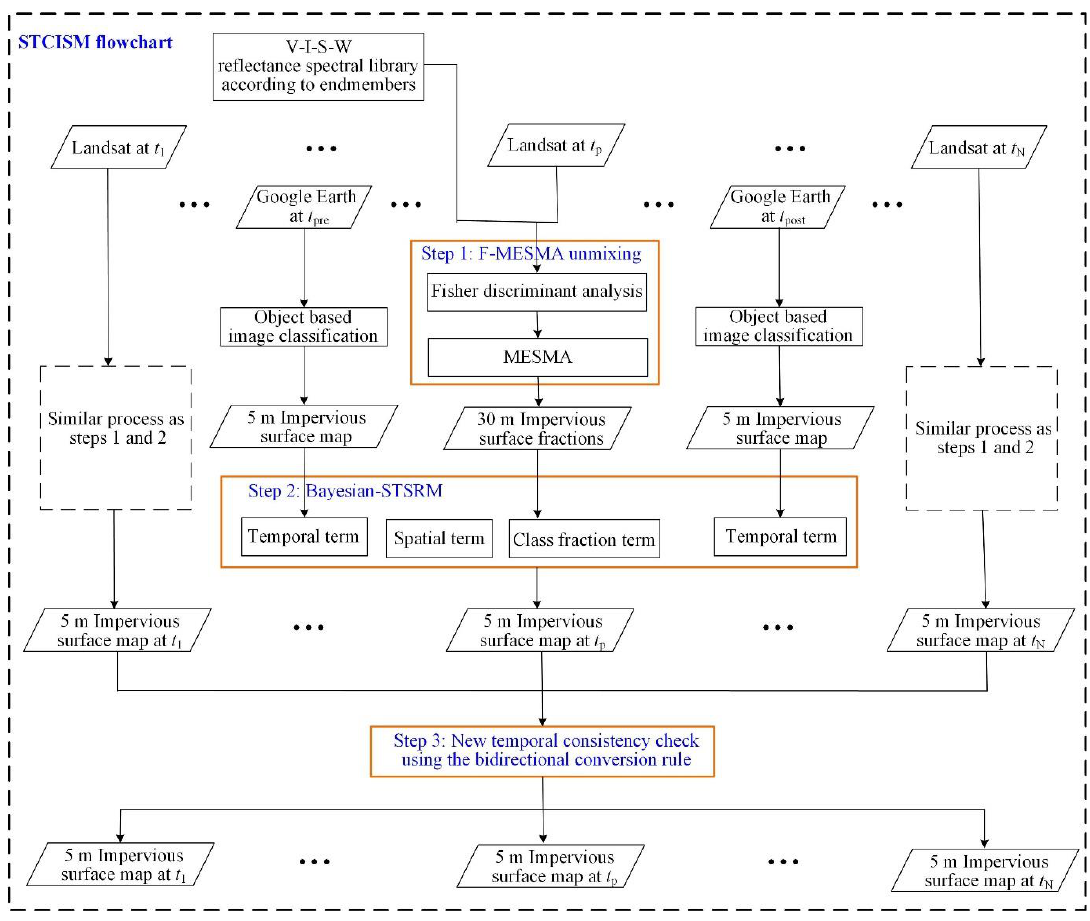
Figure 3. The flowchart of the STCISM.